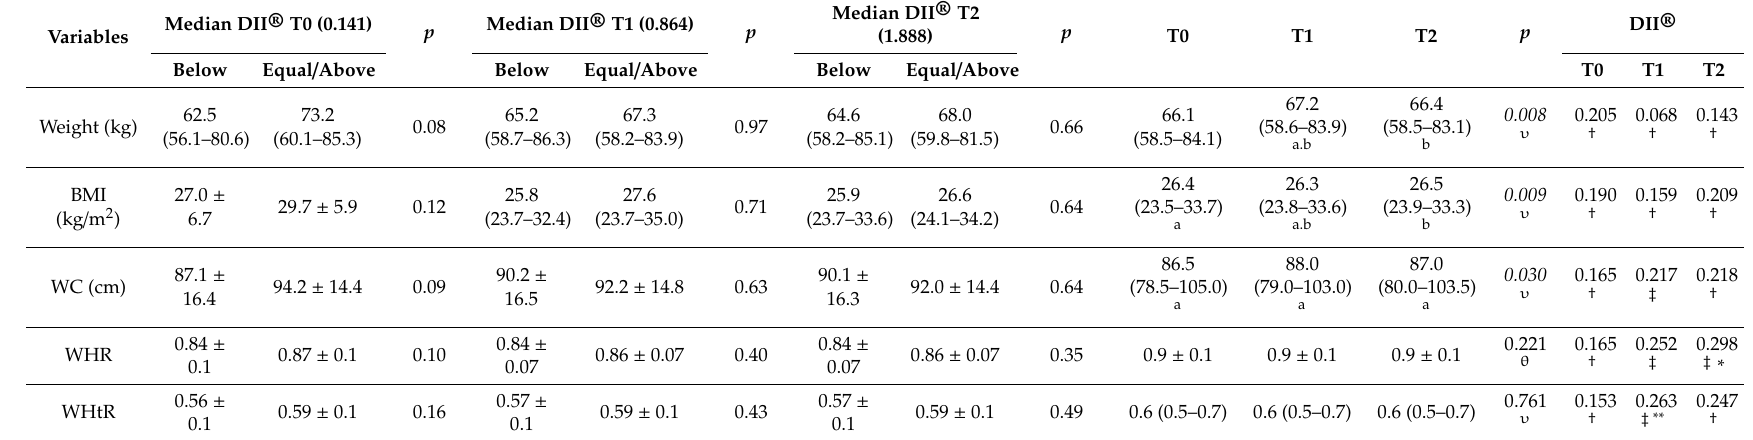
Table 2. Nutritional status and Dietary Inflammatory Index (DII ® ) of women with breast cancer in chemotherapy seen at Clinics Hospital of the Federal University of Uberlandia, Minas Gerais, Brazil, 2014–2015 (n =